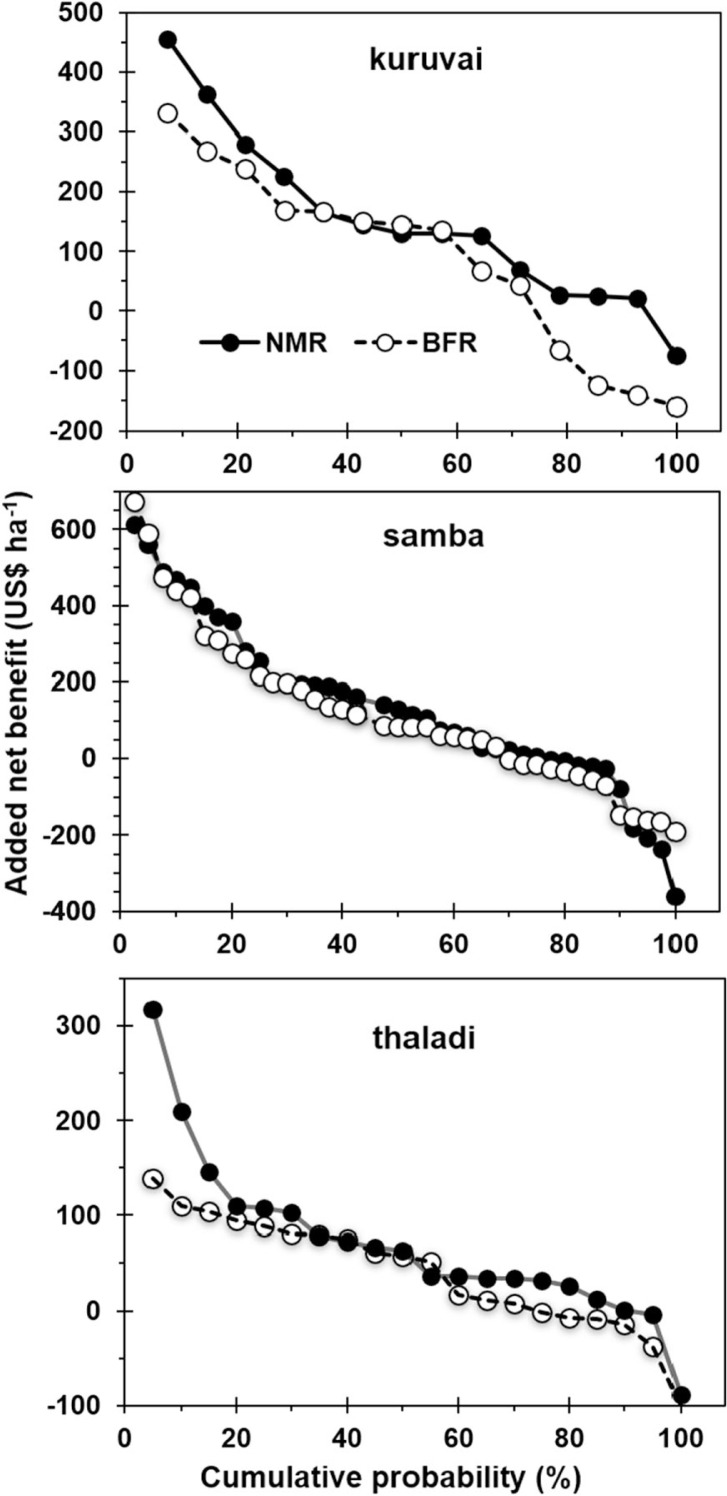
Cumulative probability of exceeding an added net benefit by switching from the farmer’s fertilizer practice (FFP) to either field-specific nutrient management through Nutrient Manager for Rice (NMR) or a uniform fertilizer application using the blanket fertilizer recommendation (BFR) in three ricegrowing seasons in the Cauvery Delta in Tamil Nadu, India